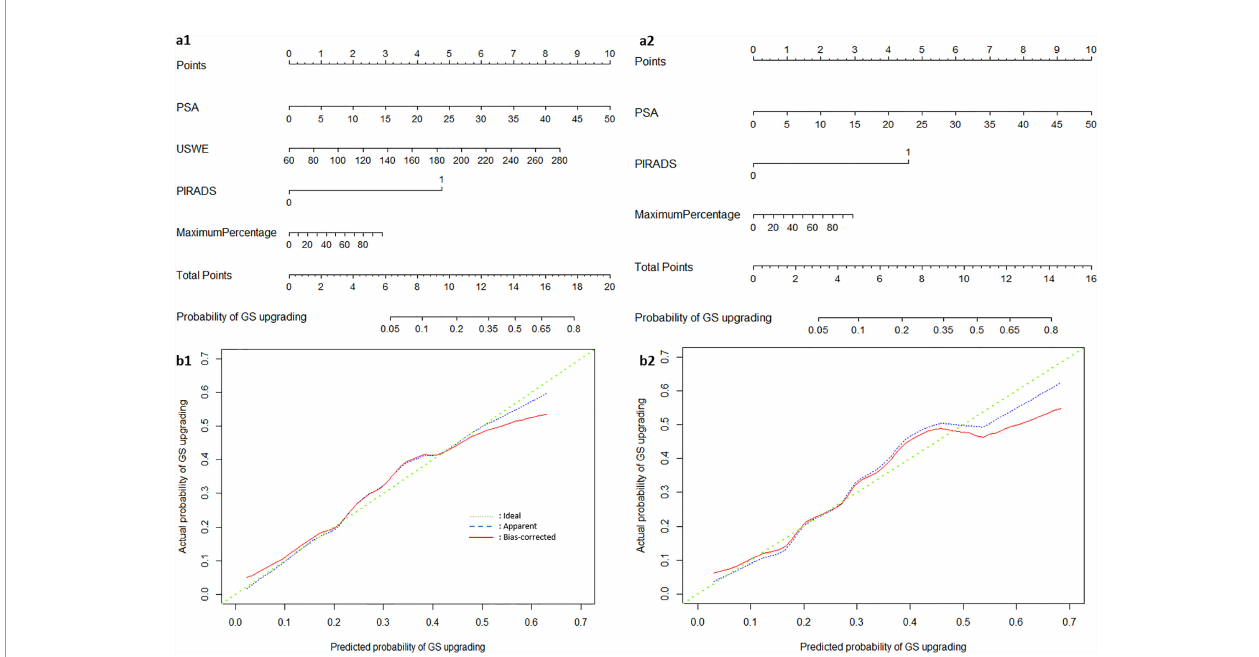
FIGURE 3 | The nomograms of Gleason Score upgrading prediction with (A1) and without USWE score (A2) . Calibration plots of observed and predicted probability of GS upgrading with (B1) and without USWE score (B2)